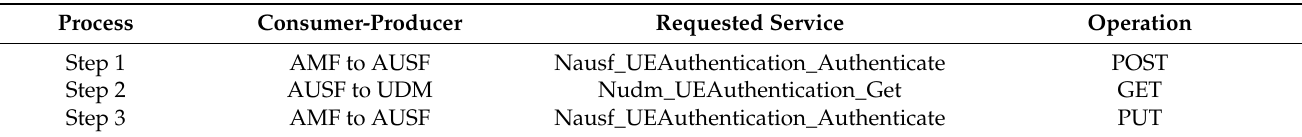
Table 4. UE authentication process